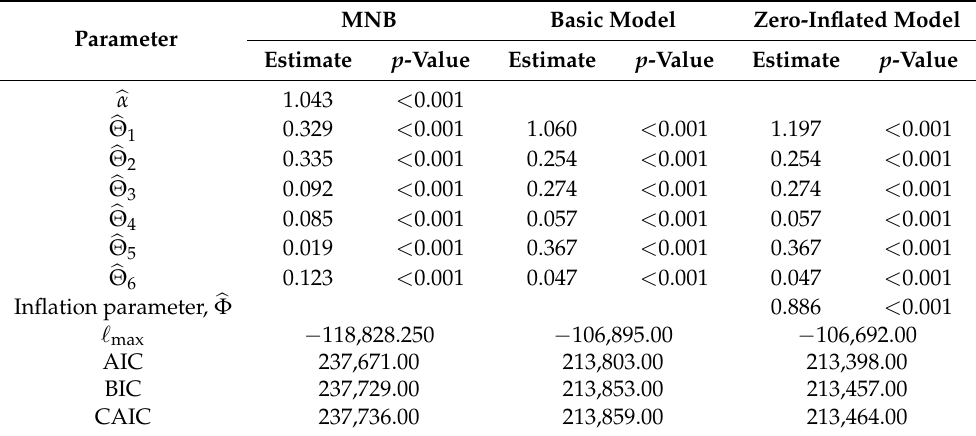
Table 3. Parameter estimates and p -values for the basic model (second and third columns) and zero-inflated model (fourth and and fifth columns). Some measures of model selection are also given for comparison purposes.